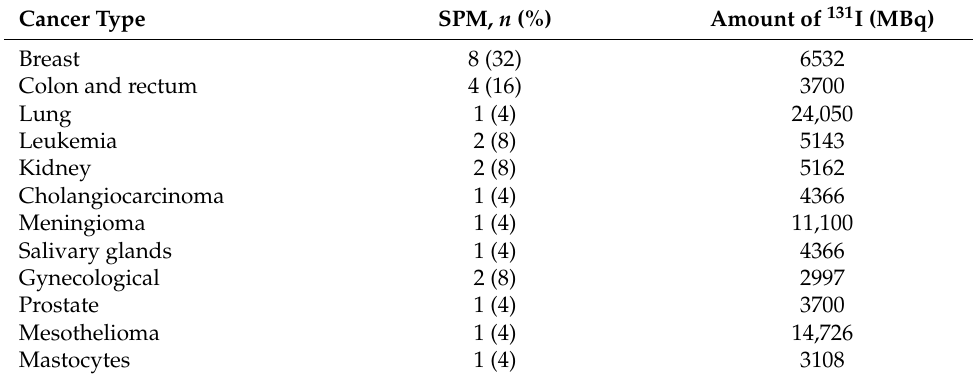
Table 2. Observed second primary malignancies and RAI activity in 25 patients.